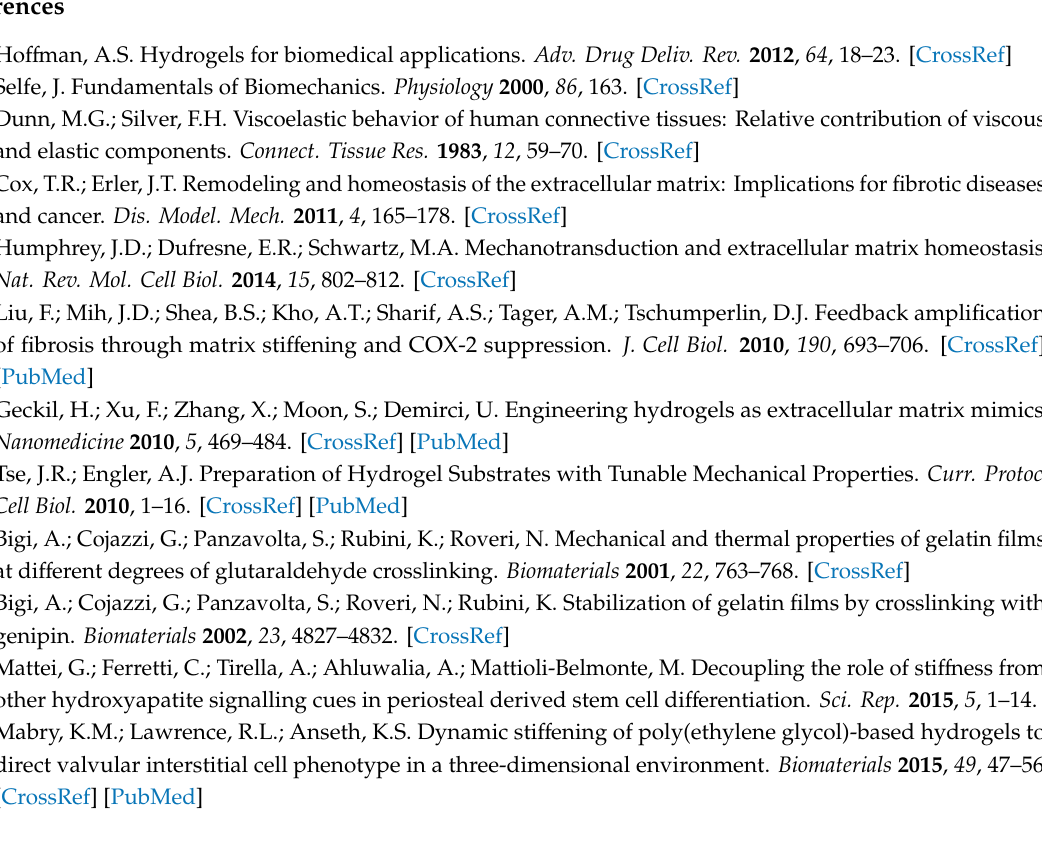
Supplementary Materials: Data plotted in the graphs in the main text and the results of the statistical are available online at http: // www.mdpi.com / 1996-1944 / 13 / 2 / 438 / s1. Author Contributions: G.M. and A.A. conceived the work; G.M. and L.C. performed the experiments; G.M., L.C., and A.A. wrote the manuscript; L.C. and A.A. revised and edited the manuscript. All authors have read and